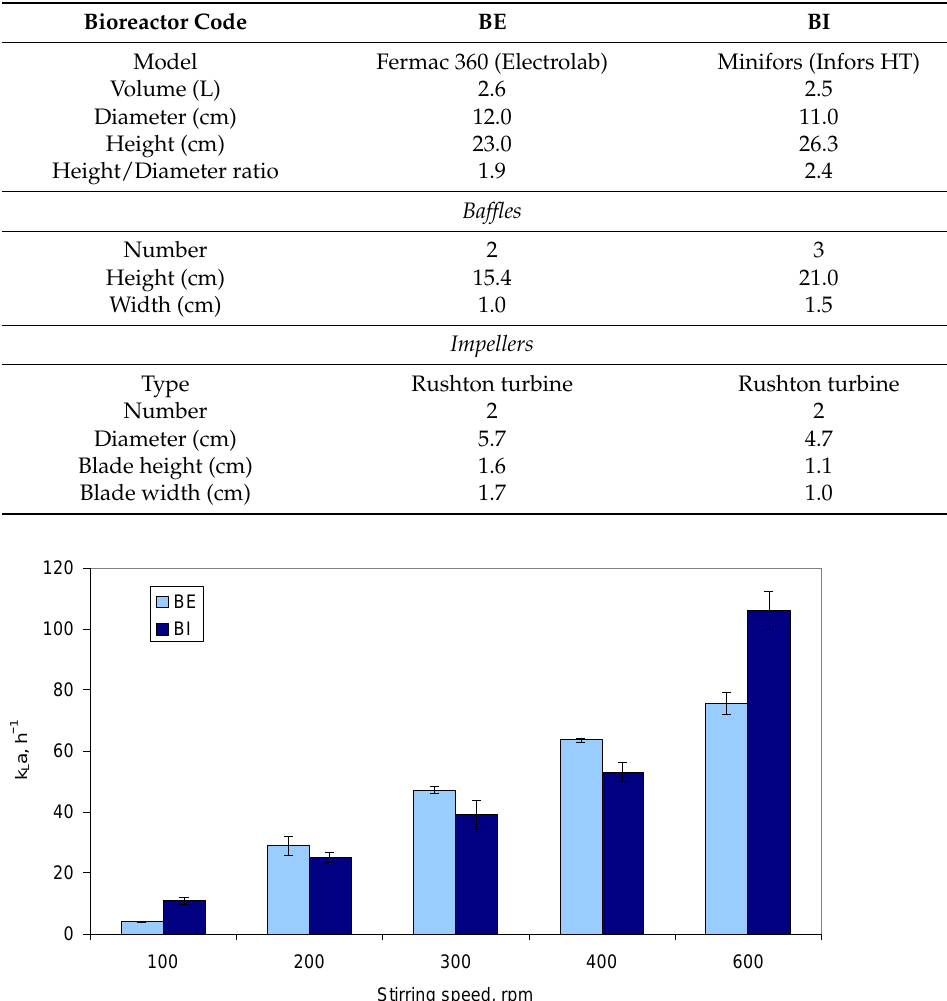
Figure 2. Volumetric mass transfer coefficient, k L a , attained at different stirring speeds in the bioreactors used. Values determined in the absence of cells with an air flow rate of 1 vvm.